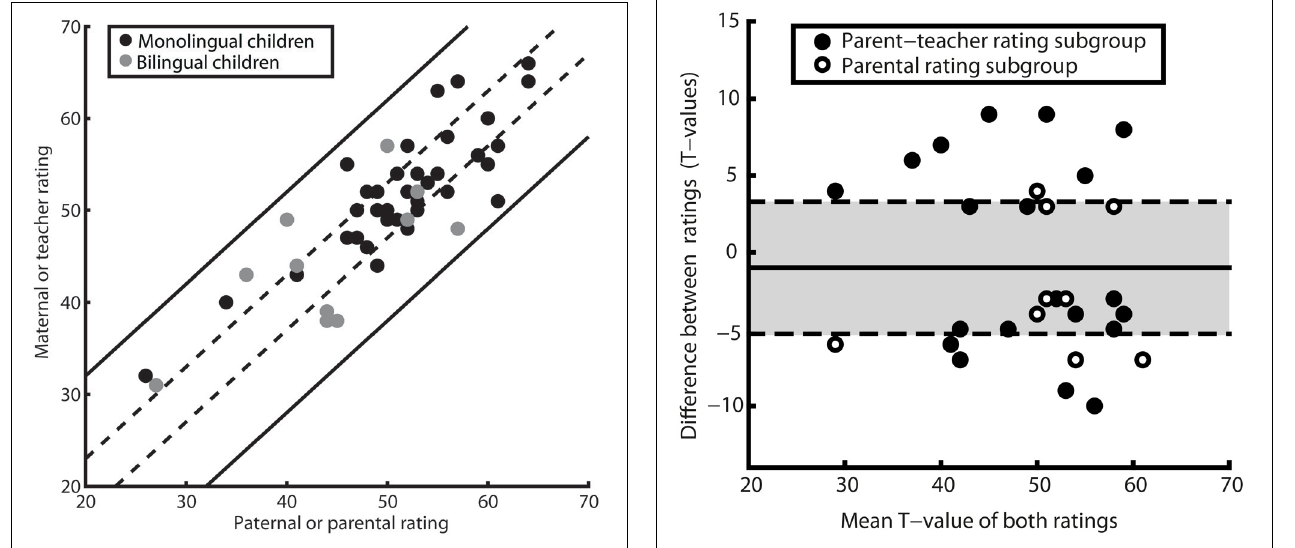
FIGURE 3 | Scatter-plot of children’s ratings. Every dot represents two ratings provided for a child. For the parent–teacher rating subgroup, parental ratings are on the x -axis, teacher ratings are on the y -axis, for the parental rating subgroup, paternal ratings are on the x -axis, maternal ratings are on the y -axis. Ratings for bilingual children are represented by gray, for monolingual children by black dots. Dashed lines enclose statistically identical ratings as calculated on the basis of the manual-provided test-retest reliability (less than 3 T -points difference; 23 out of 53 rating pairs). Straight lines enclose statistically identical ratings as calculated on the basis of the inter-rater reliability (ICC) in our study (less than 12 T -points difference).